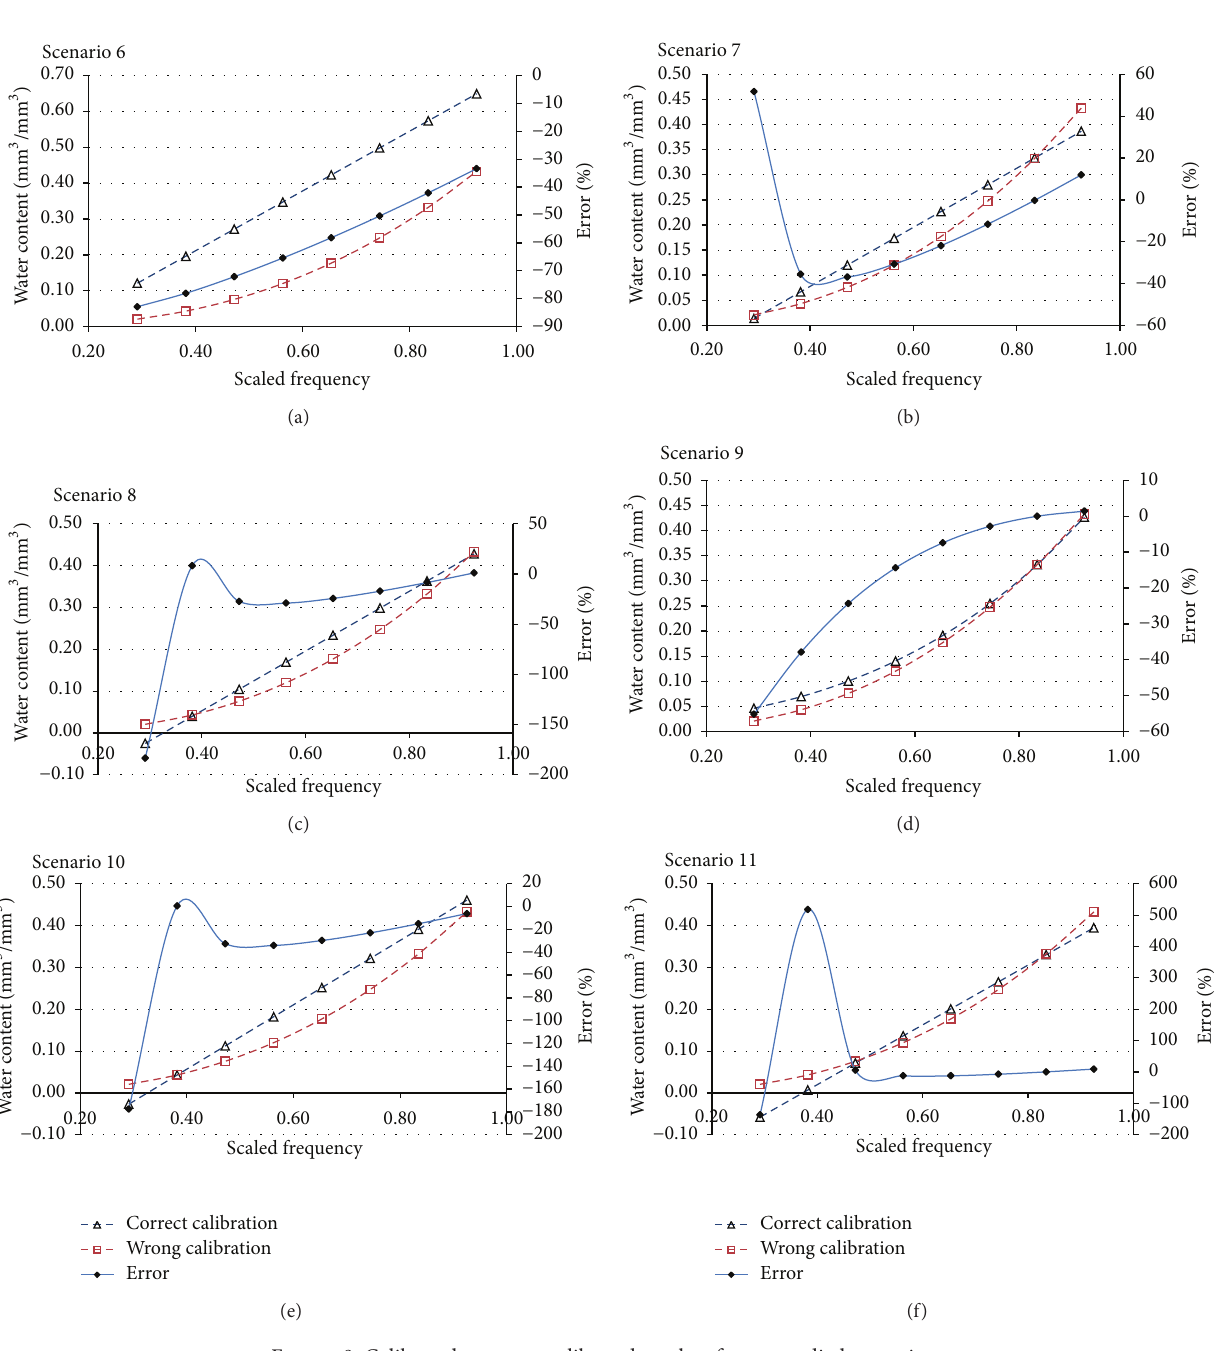
Figure 8: Calibrated versus uncalibrated results of some studied